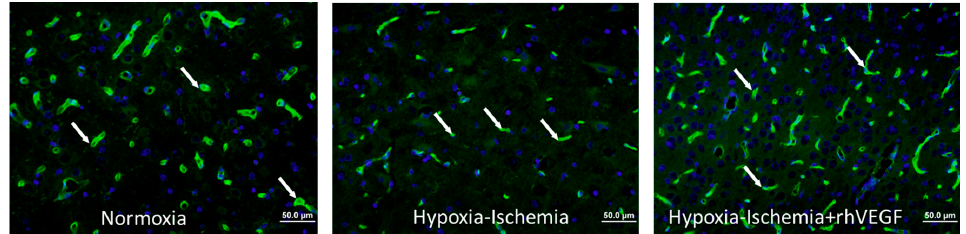
Figure 2. Representative immunohistochemistry staining with (from left to right) Hoechst Nuclear stain, (the arrow demonstrates nucleus), isolectin endothelial cell marker, arrow pointing to blood vessel), and merged images showing Isolectin-FITC (green) around the nucleus (blue) indicating a blood vessel